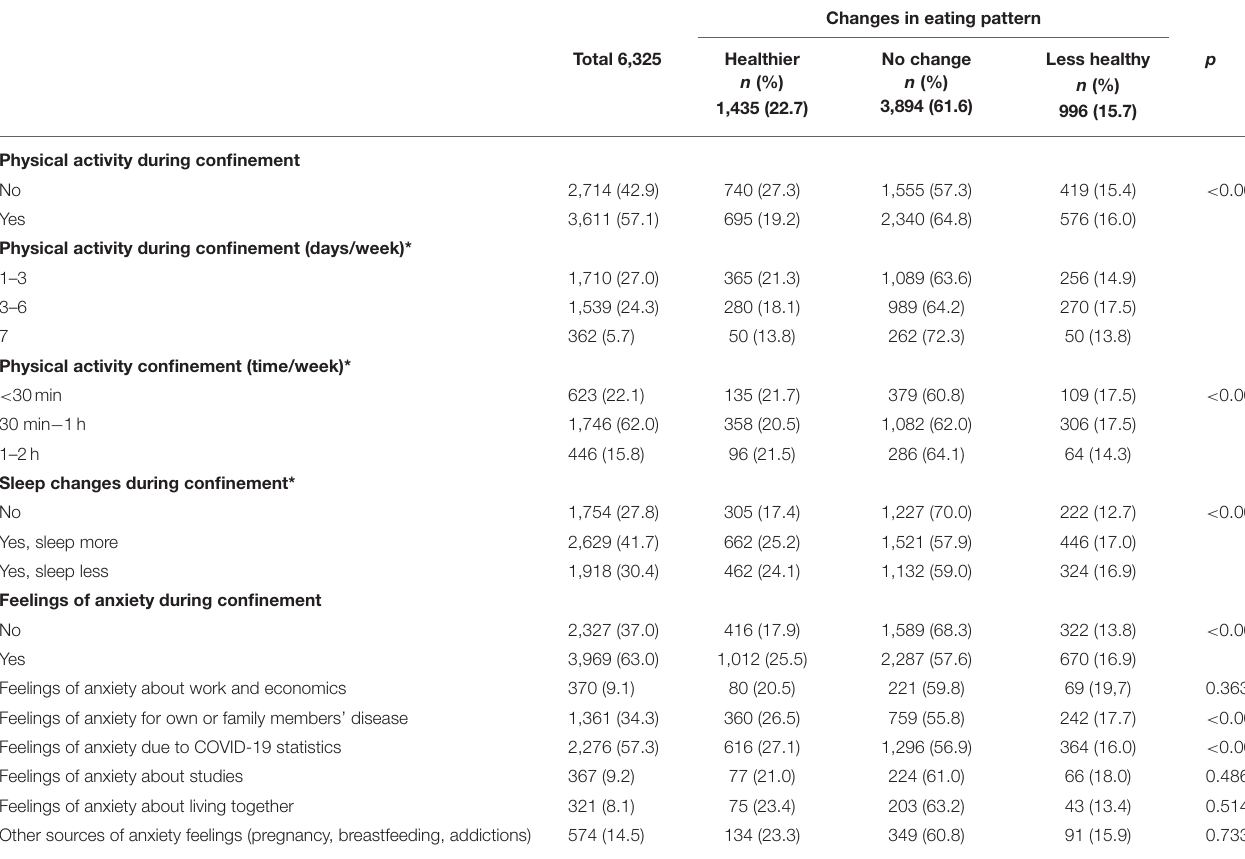
TABLE 2 | Physical activity, sleep changes and anxiety, according to direction of changes in eating patterns during the confinement due to COVID-19